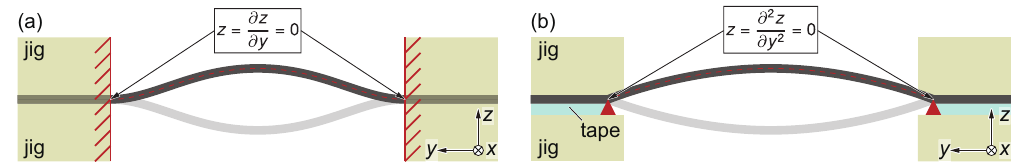
Figure 8. Schematic illustration of the boundary. ( a ) Fixed condition based on beam theory. The displacement and gradient of the membrane at the boundary are equal to zero. ( b ) Possible state of the actual boundary conditions of the membrane in the theoretical model. If fixation by the double-sided tape and jig is insufficient, it is possible that the displacement and bending moment would be zero, corresponding to a simply supported